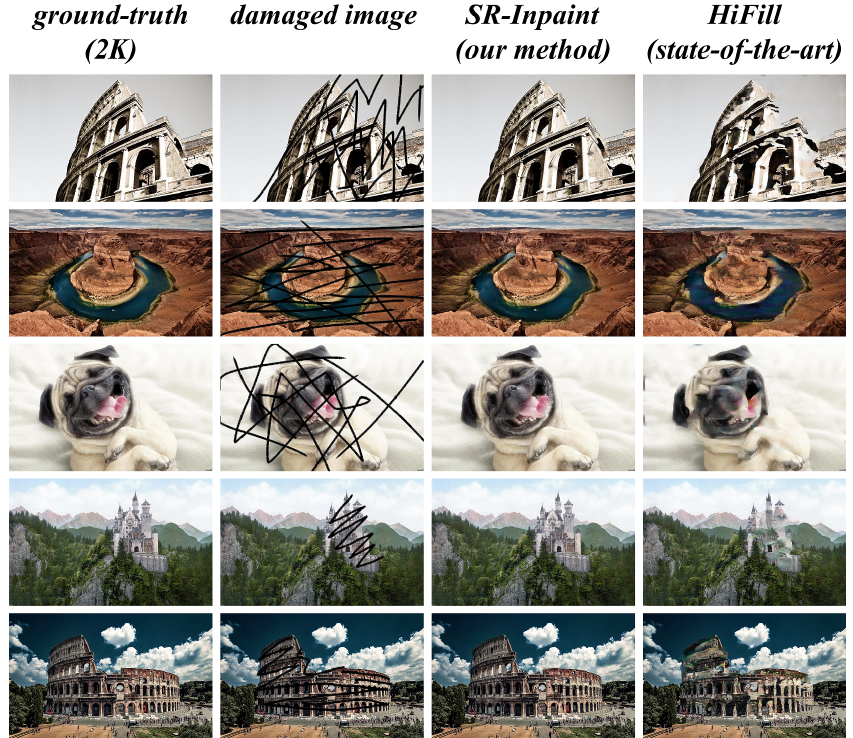
Figure 4. Example of inpainting results for 2K resolution: ( left to right ) ground-truth, input damaged image, inpainted image by our method, inpainted image by state-of-the-art